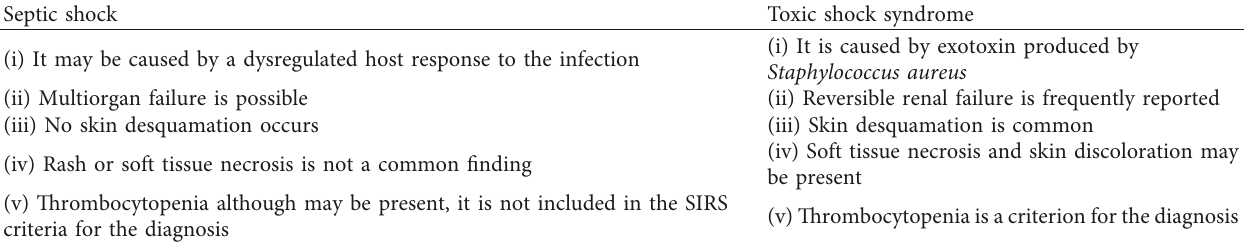
Table 2: Salient differences between septic shock and toxic shock syndrome [1, 5, 7, 11, 12]. Septic